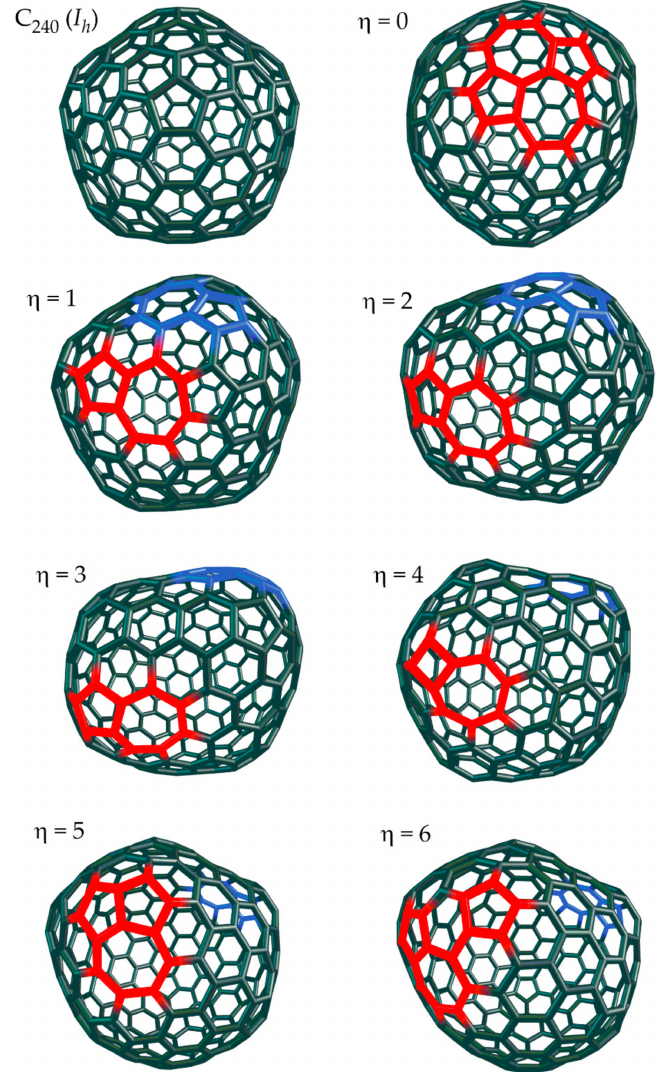
η Figure 5. The DFT-optimized C fullerene structures. Blue and red colorings correspond to the static 240 and migrating (Stone–Wales wave) defects, respectively (except for the case of η = 0 whereby the defect polygons are fused). Table 1. Structural parameters of original and defected C 240 fullerenes (DFT